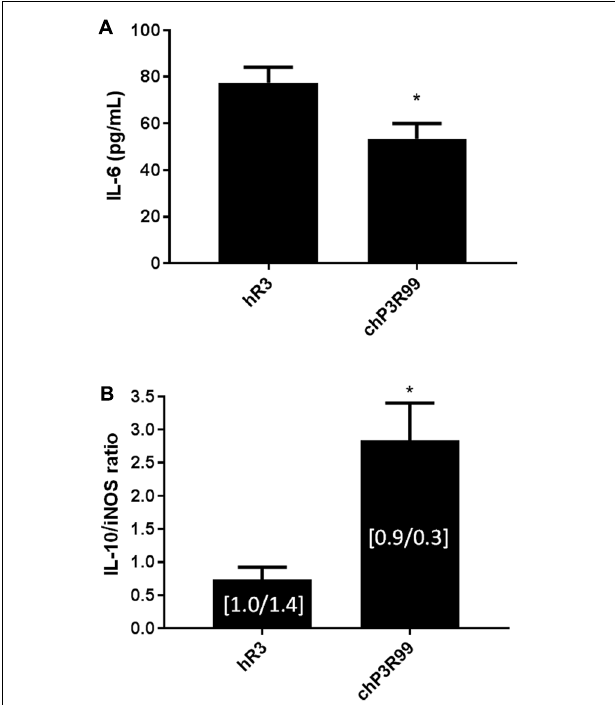
FIGURE 4 | Effect of chP3R99 administration on circulating IL-6 levels and on the ratio of aortic IL-10 to iNOS expression. (A) IL-6 concentrations in sera at week 28 in mice treated with chP3R99 or isotype-matched control hR3. (B) Bar graphs show the ratio of aortic IL-10 to iNOS mRNA levels in chP3R99 or isotype-matched control hR3 as assessed by qPCR. Data are mean ± SEM of 10 (IL-6) and 5 (IL-10/iNOS ratio) mice per group. Inserts in bar graphs are the mean values of relative IL-10 and iNOS gene expression, respectively. Quantitative data are representative of two independent experiments. ∗ represents p < 0.05 vs. isotype-matched control hR3, Mann–Whitney U